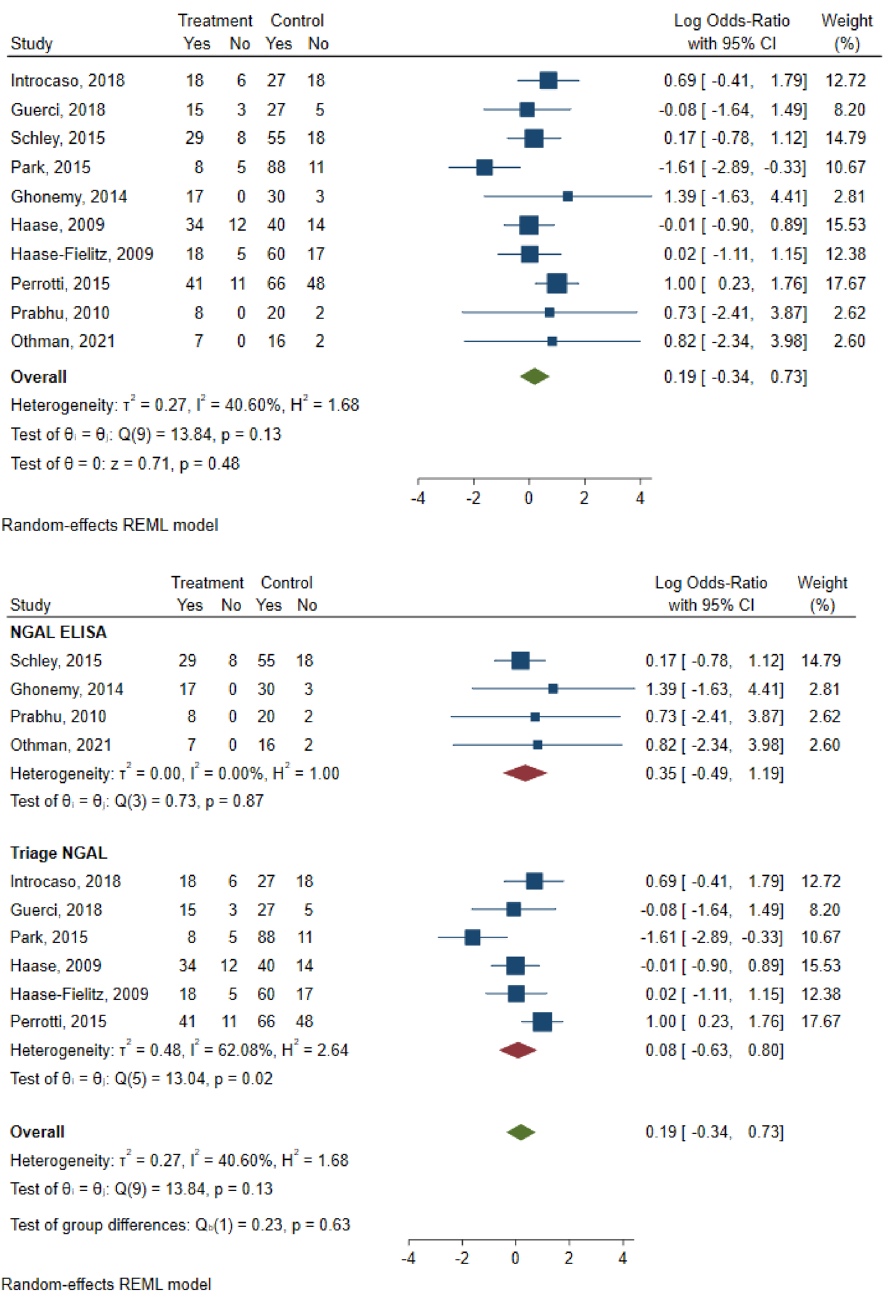
Figure 7. Random effects-meta-analysis of odds ratios and subgroup analysis in the 4–8 h